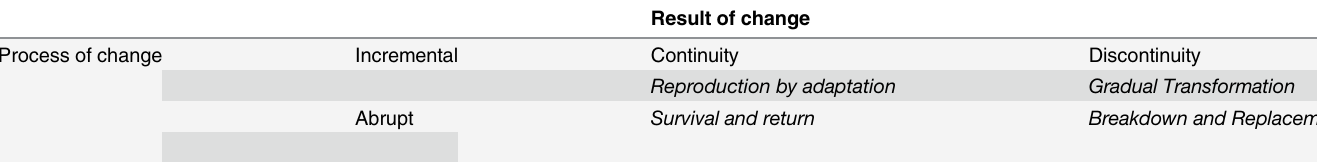
Table 1. Types of institutional change